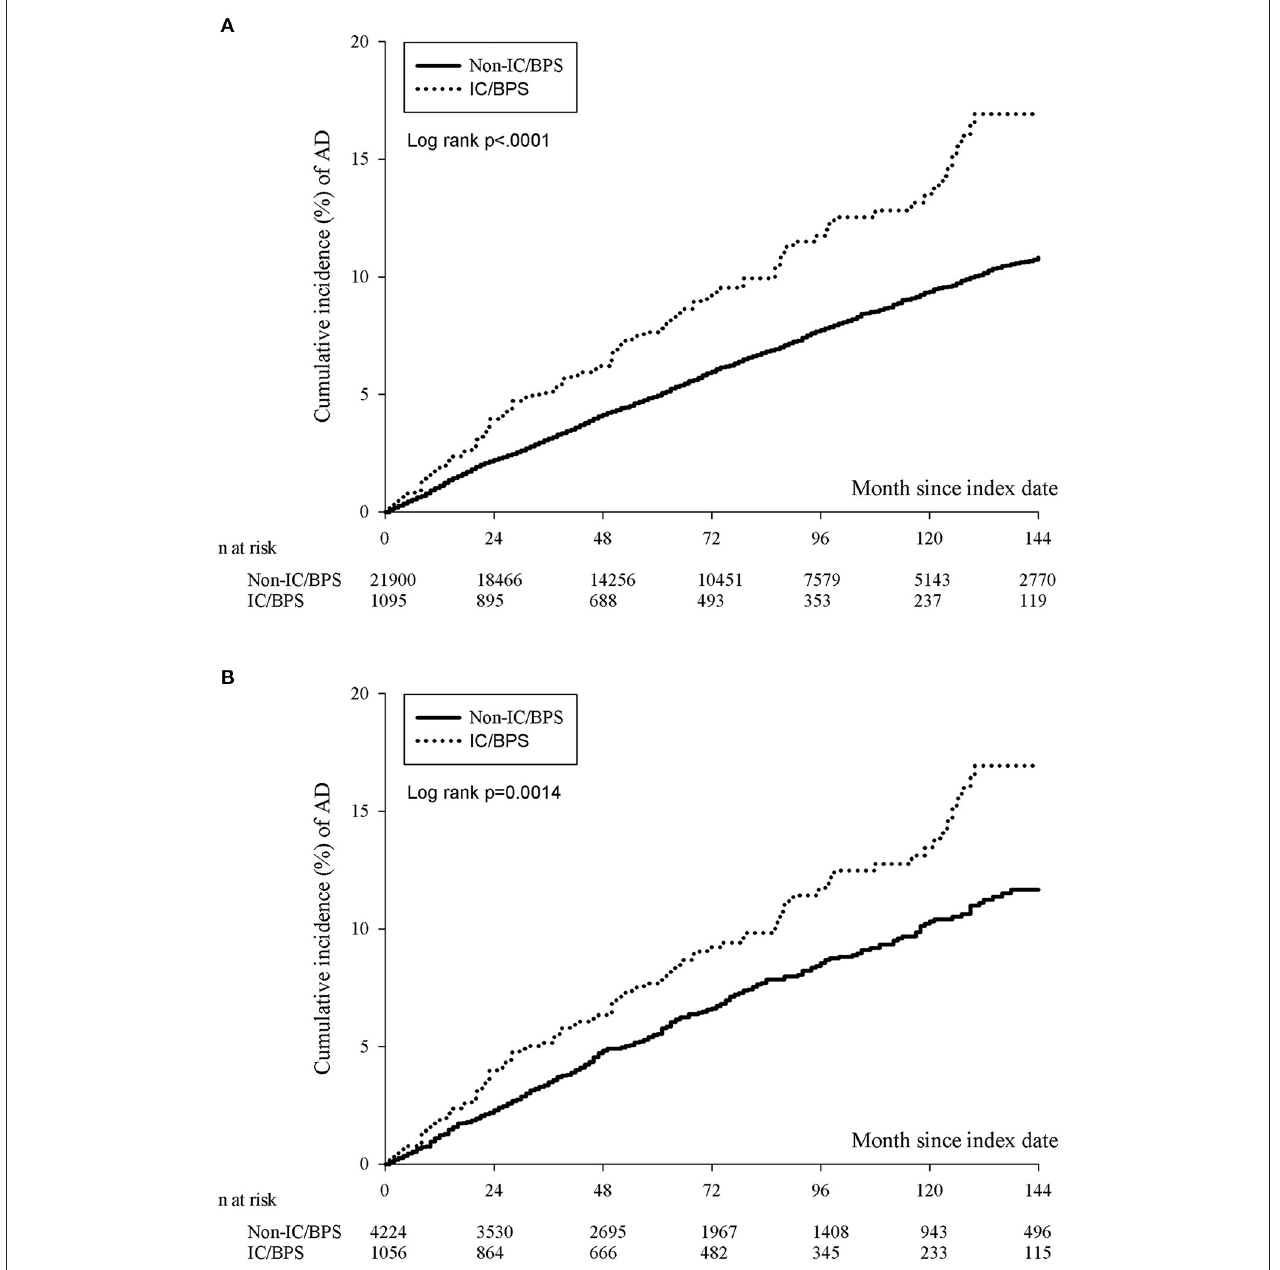
FIGURE 2 | The cumulative incidence of ADs in participants with IC/BPS before (A) and after (B) PSM. The IC/BPS group was significantly higher than that in those without IC/BPS (log-rank test, p = 0.0014). IC/BPS, interstitial cystitis/bladder pain syndrome; ADs, autoimmune diseases; PSM, propensity score matching.